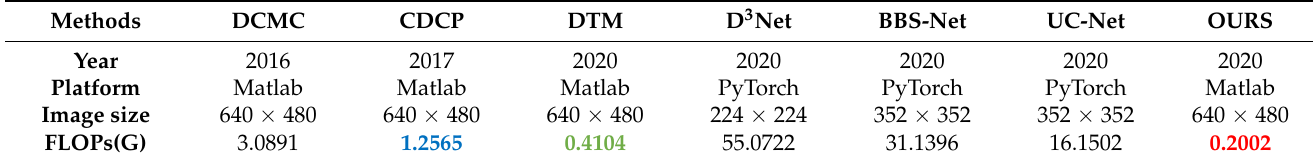
Table 2. Computational complexity comparison with traditional-based and deep learning-based RGB-D saliency detection methods. Red , green and blue indicate the best, second and third performances.